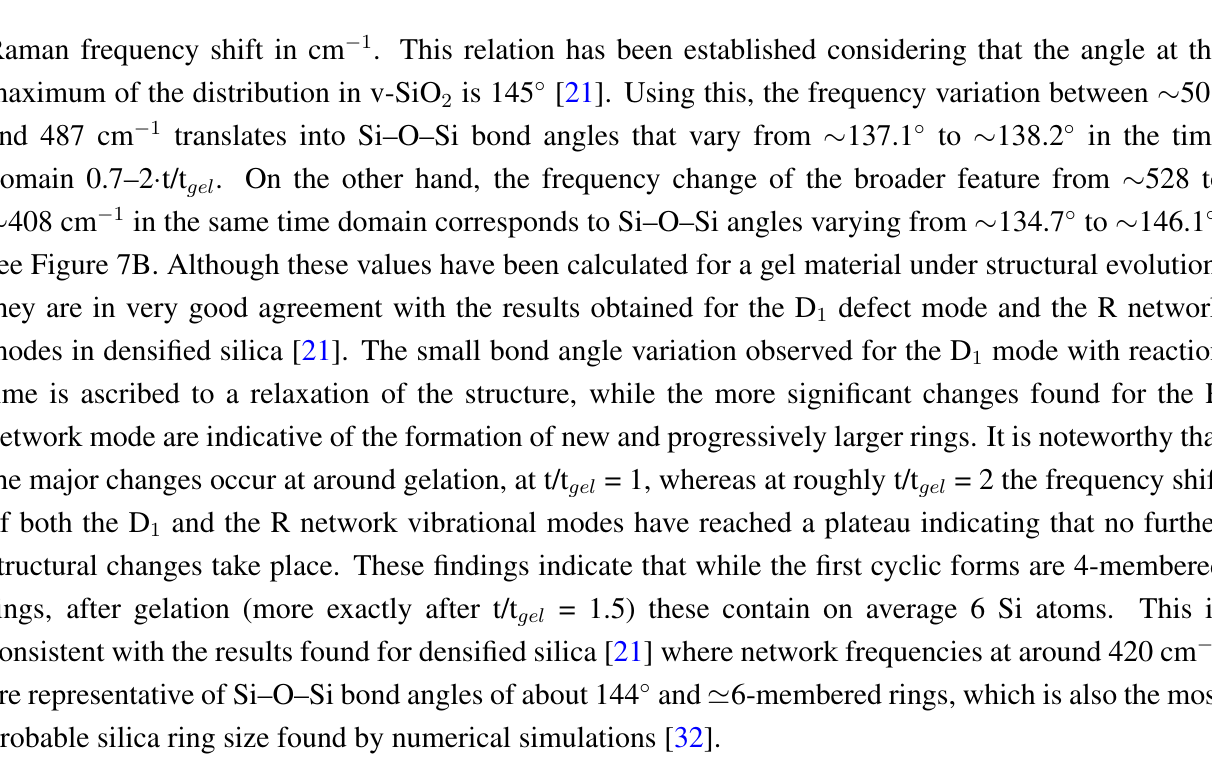
Figure 8. Raman spectra recorded on the aged gel (a) and aged ionogel (b), i.e. , six months after synthesis. The fitting components are shown as dashed